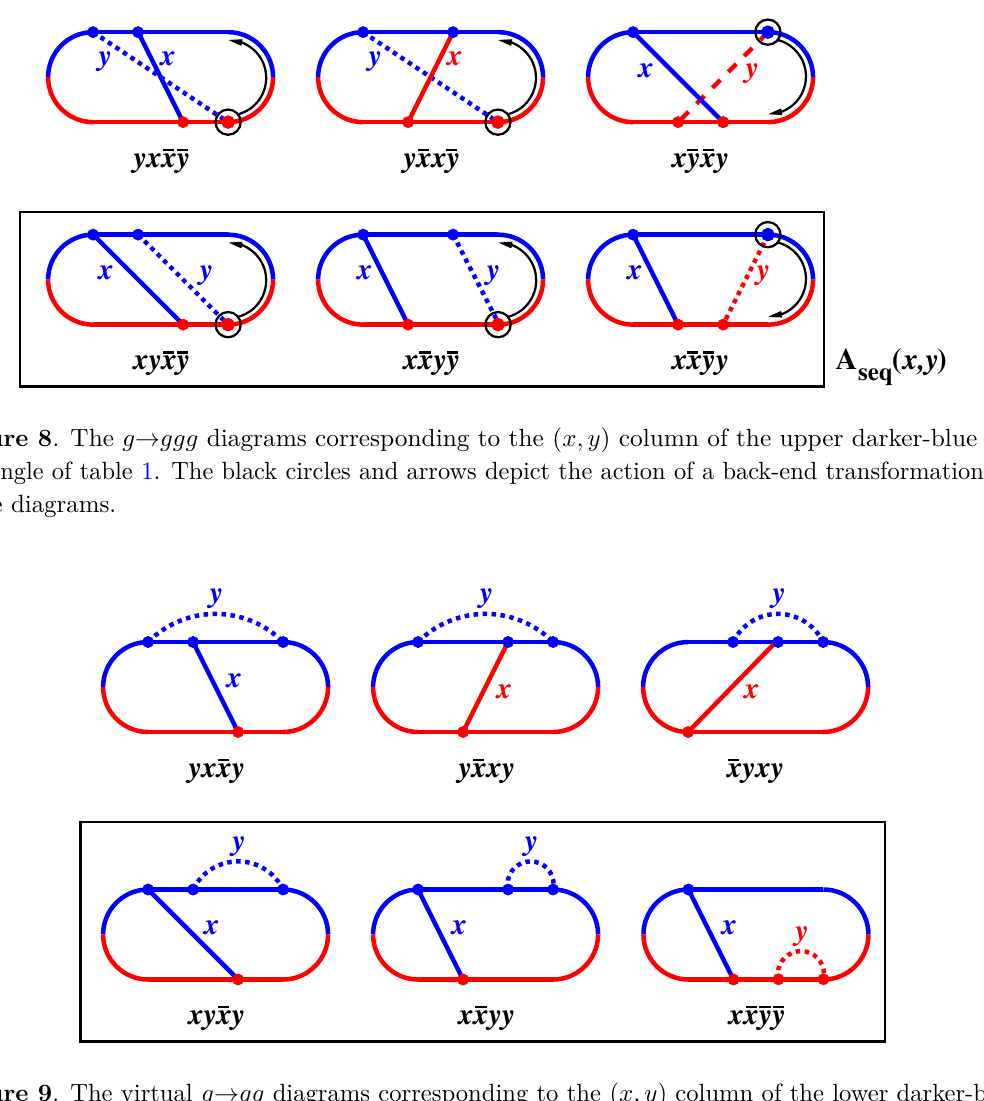
Figure 9 . The virtual g → gg diagrams corresponding to the ( x, y ) column of the lower darker-blue ( α ) rectangle of table 1.